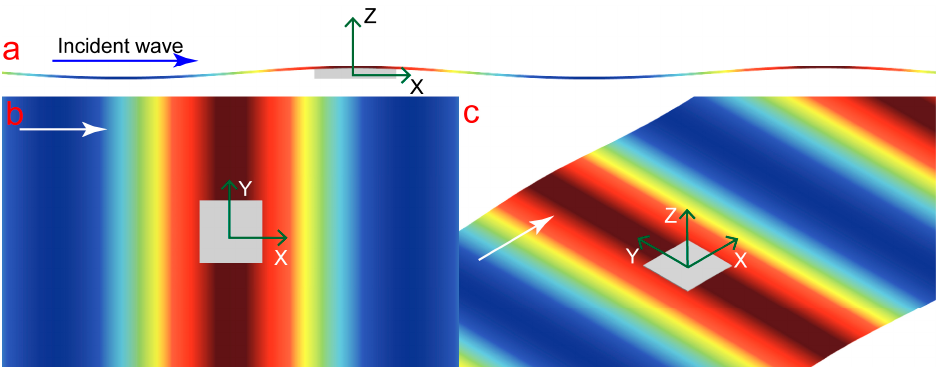
Figure 7. Motion coordinates of ice floe and waves. ( a ) Coordinates of floating ice and the wave in side view; ( b ) Coordinates of floating ice and the wave in top view; ( c ) Coordinates of floating ice and the wave in 3 dimensional view.